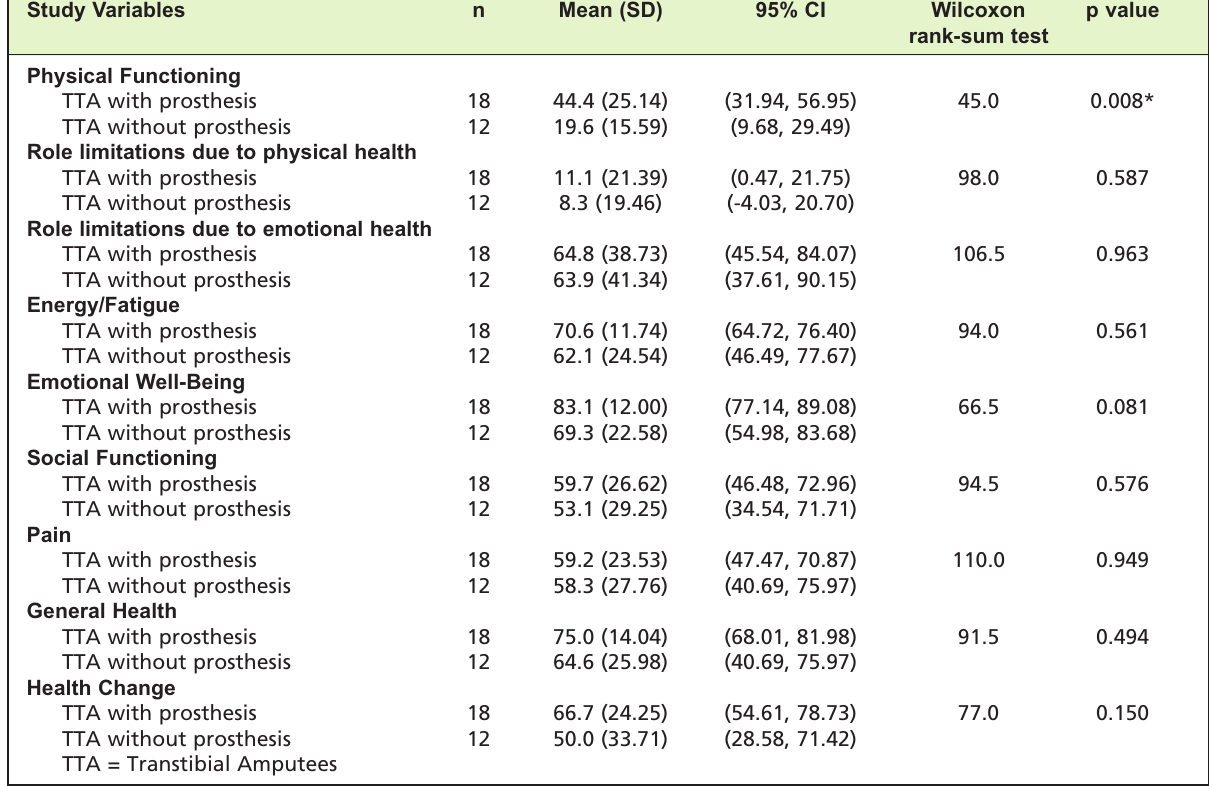
Comparison in QoL scores (SF-36) between TTA with prosthesis and TTA without Table III: